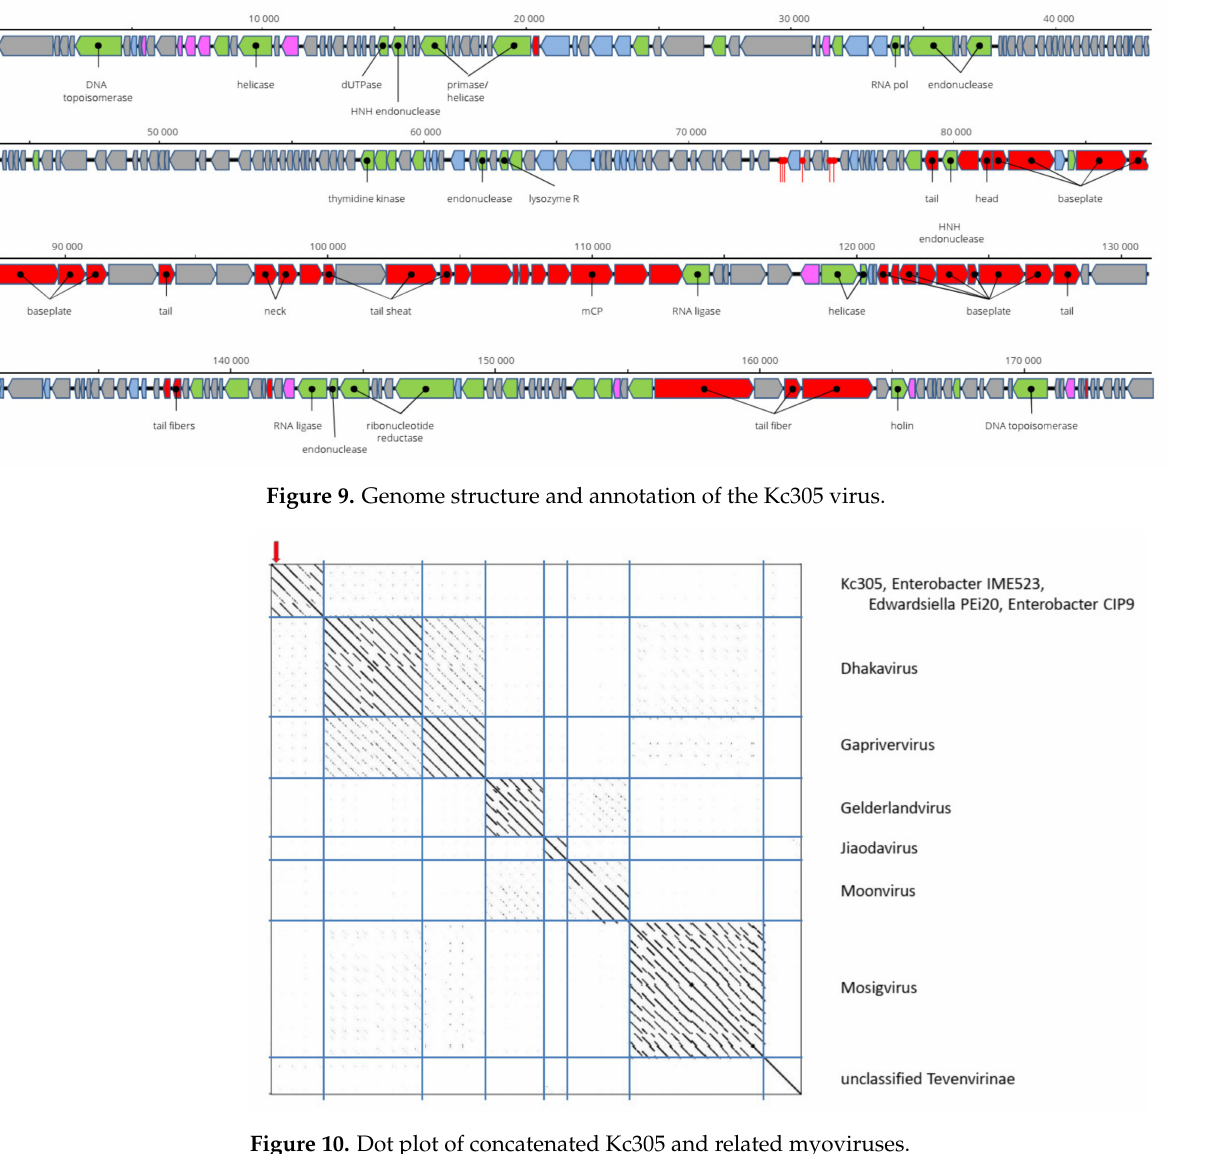
Figure 10. Dot plot of concatenated Kc305 and related